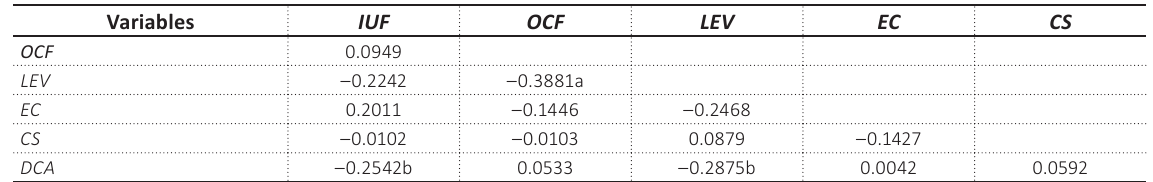
Table 2. Correlation matrix of research